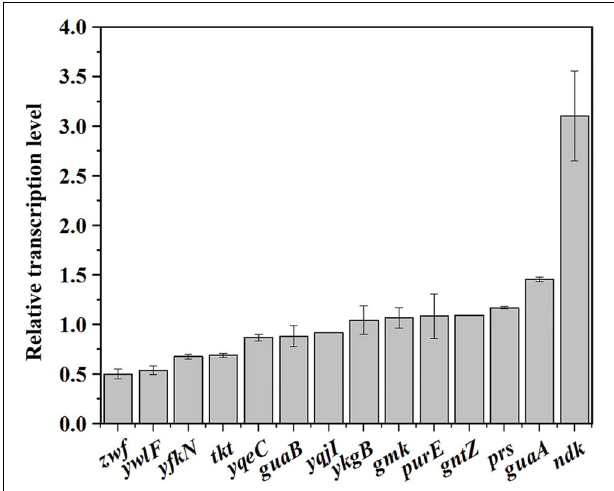
FIGURE 4 | Investigation of the mechanism of riboflavin overproduction in the rpe mutant. Relative transcriptional levels of genes in the pathways that provide precursors for riboflavin